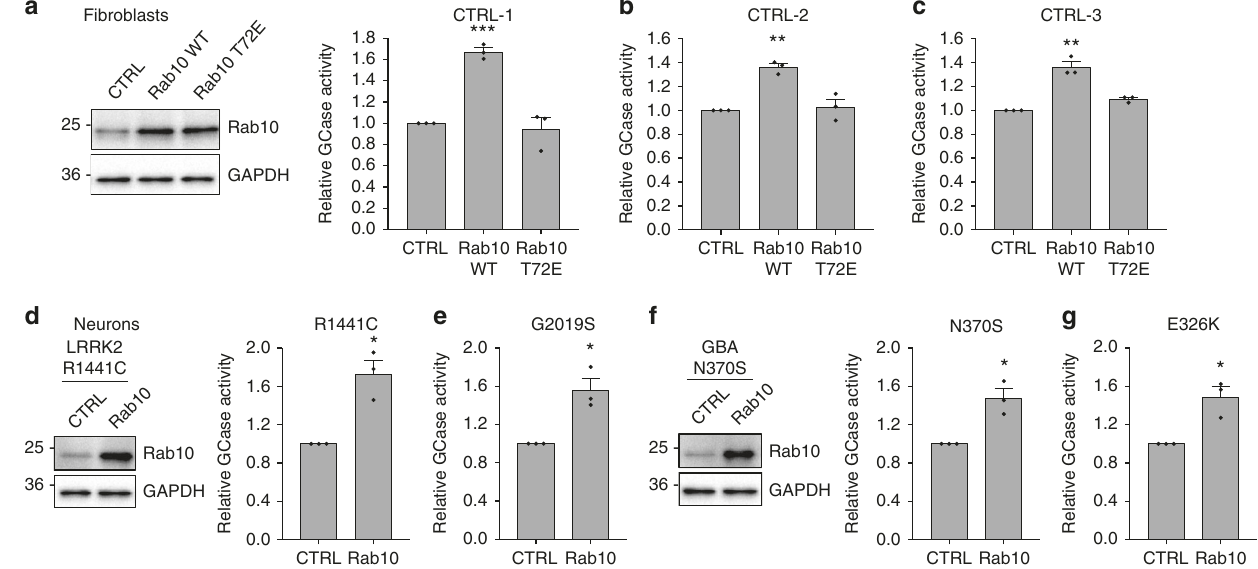
Fig. 6 Overexpression of Rab10 WT increases GCase activity in fi broblasts and DA neurons. Relative GCase activity in control fi broblasts transduced with lentivirus expressing GFP, Rab10 WT or Rab10 T72E a – c . Representative western blots showing overexpression of Rab10 and Rab10 T72E in control (CTRL) fi broblasts ( a right). Relative GCase activity in DA neurons containing LRRK2 R1441C d , LRRK2 G2019S e , GBA1 N370S f , or GBA1 E326K g mutations transduced with CTRL or Rab10 lentivirus for 10 days, with representative western blots showing overexpression of Rab10 in DA neurons ( f right). The data are presented as the mean ± SEM, n = 3; * p < 0.05, ** p < 0.01, *** p < 0.001, using one-way ANOVA followed by Tukey ’ s multiple comparison post hoc test a – c , or paired two-tailed t -test d – g . Source data are provided as a Source Data fi